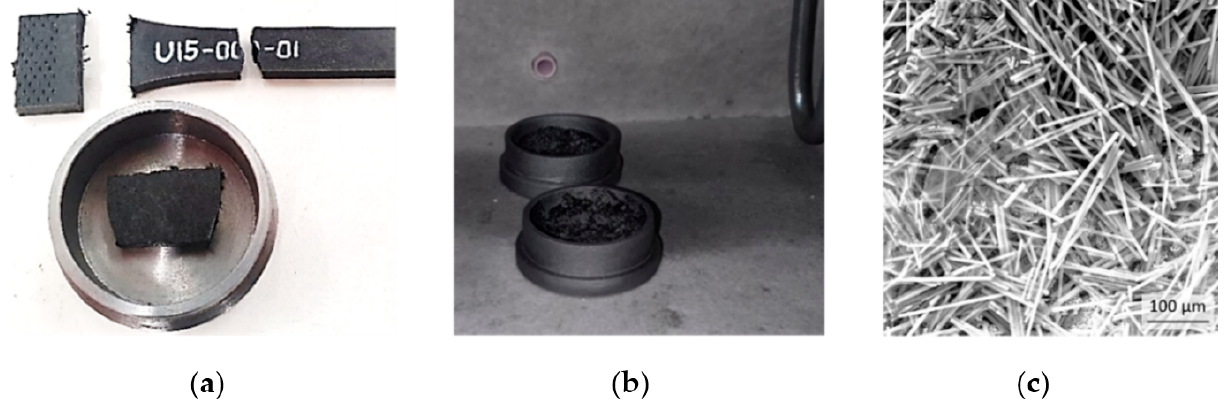
Figure 3. Short fiber extraction from composite: ( a ) Sample preparation; ( b ) burning samples in the oven; ( c ) fibers after matrix burning.